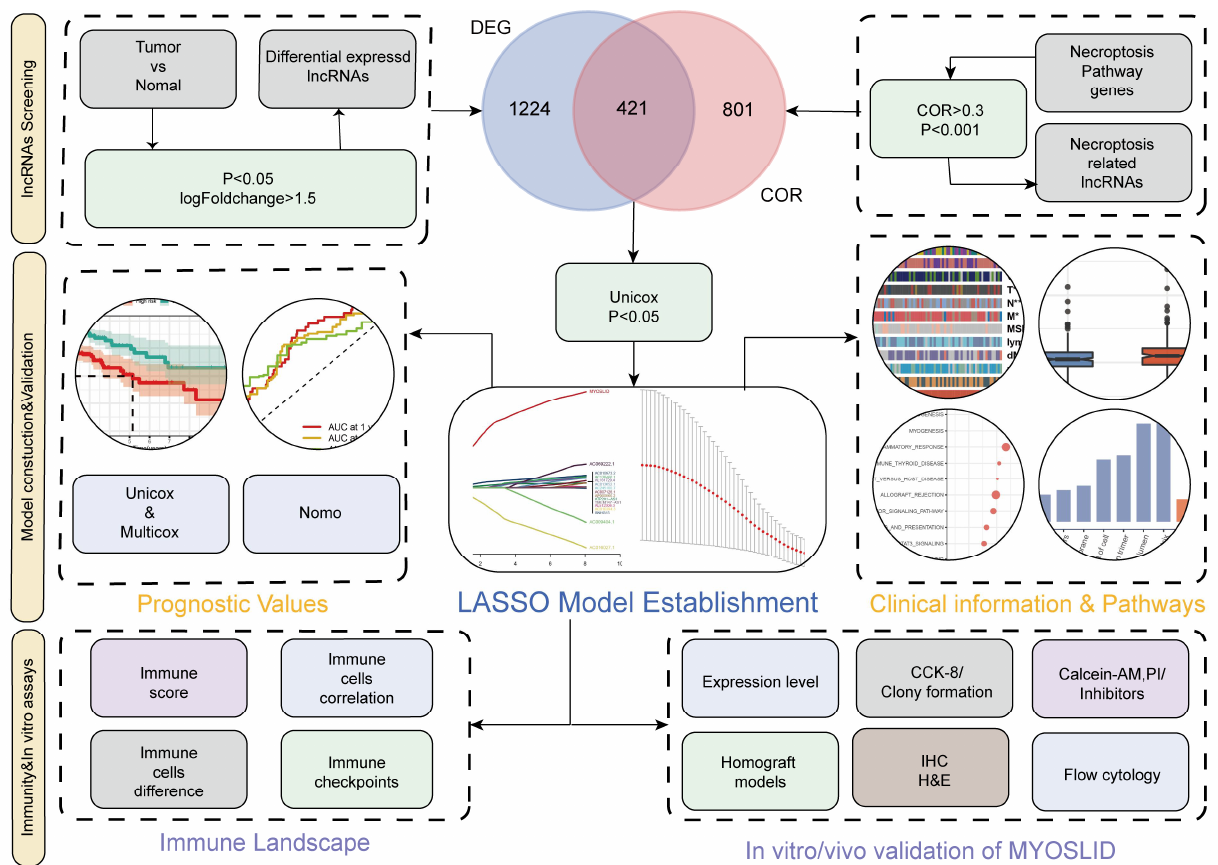
Figure 1. Study flowchart.